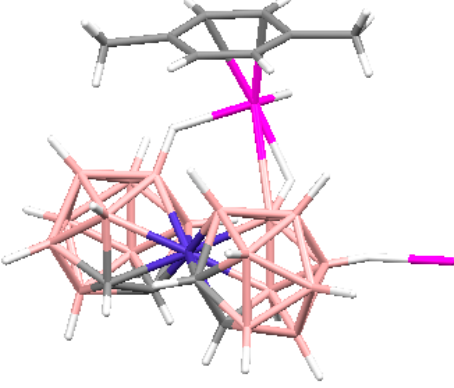
Figure 99. Fragment of X-ray structure of {Ag( η 2 - p -xylene)[3,3’-Co(1,2-C 2 B 9 H 11 ) 2 ]} n .